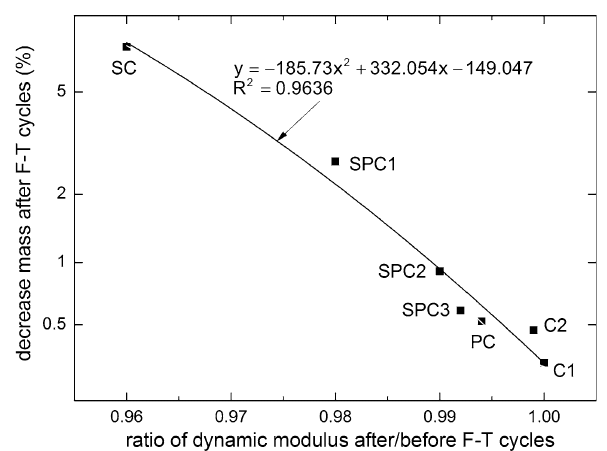
Fig. 12 Relationship between mass loss and dynamic mod- ulus ratio after/before F–T